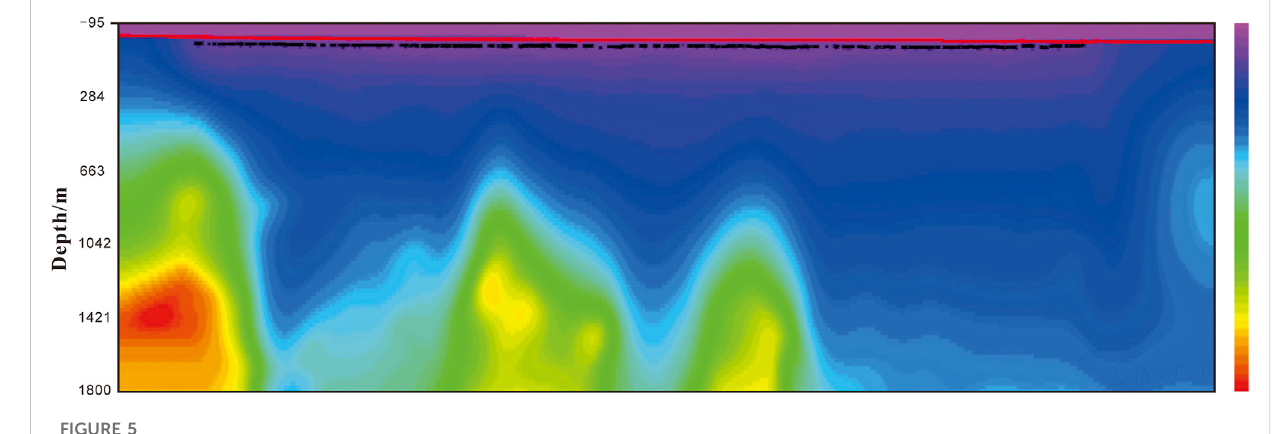
FIGURE 5 Shallow velocity model retrieved from fi rst